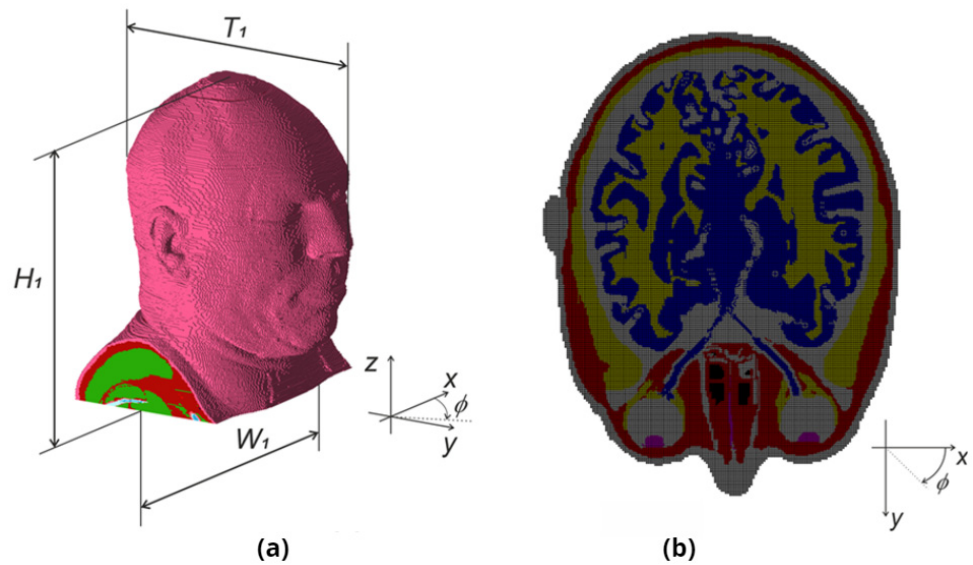
Figure 2. Heterogeneous model of head in the XFdtd program: ( a ) model view; ( b ) horizontal plane cross-section at the level of the eyeballs.